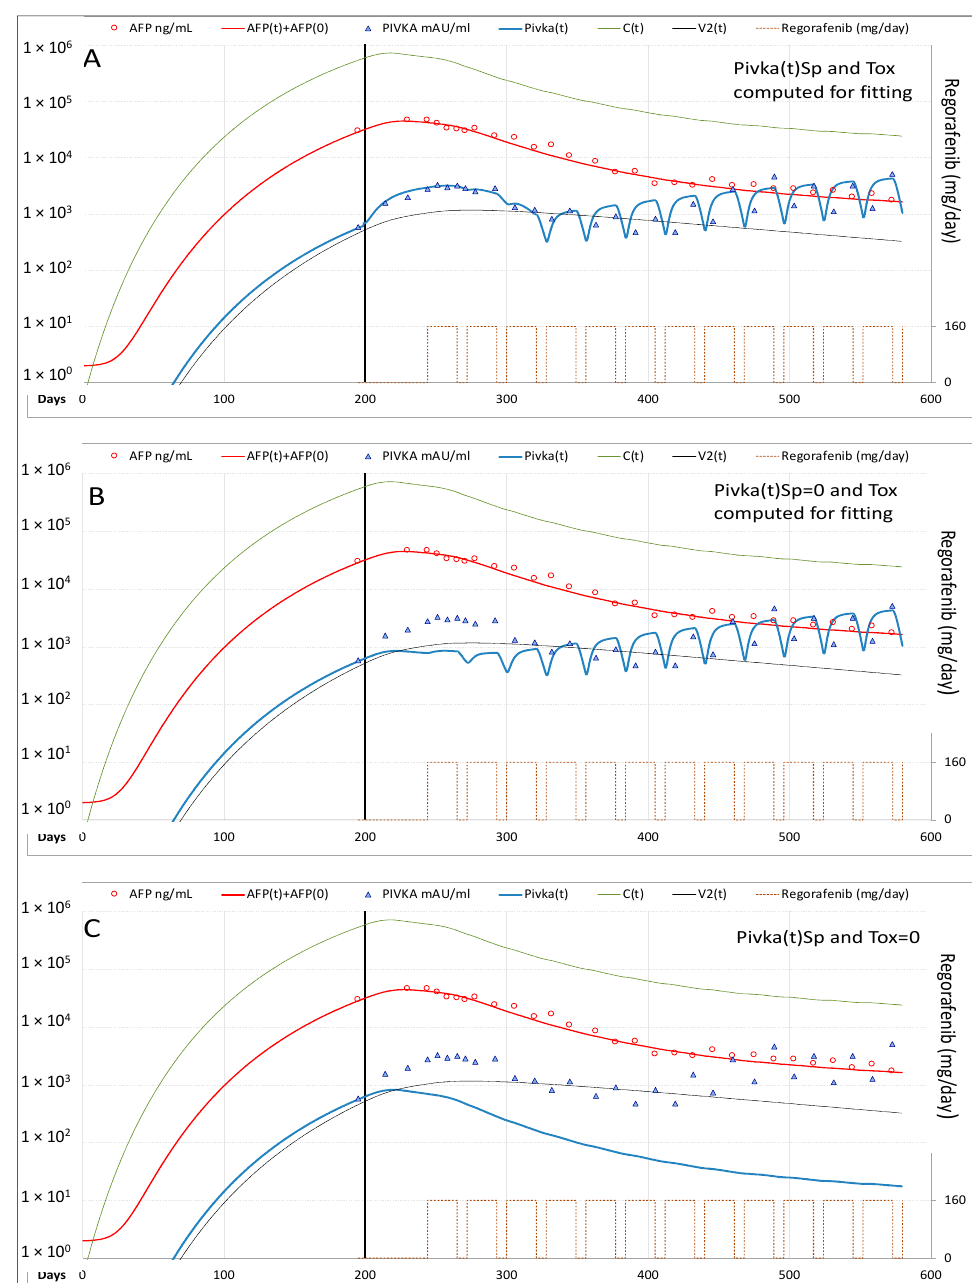
Figure 6. Model fitting of measured variables in Case-3 ( A ) Best fitting of AFP and PIVKA-II serum levels. AFP decline well correlated to C(t) decline, whereas PIVKA-II levels showed more complex kinetics, which appear influenced by the schedule of regorafenib treatment. The increase of PIVKA-II production observed in the first 3 months was fitted including in the model the potential effect of ischemia induced by the drug on cancer cells [Pivka(t) Sp]. The later PIVKA-II behavior, characterized by rapid fluctuations, was strongly influenced by the treatment schedule; this behavior could be explained considering that regorafenib may also exerted anti-vascular/toxic effects on non-tumor liver cells, that led to the production of a certain amount of PIVKA-II [Pivka(t) Tox]. ( B ) Best fitting of AFP and PIVKA-II obtained without including Pivka(t) Sp. ( C ) Best fitting of AFP and PIVKA-II obtained without including both Pivka(t) Sp and Pivka(t) Tox. Legend : AFP = measured AFP; AFP(t) = model computed AFP; AFP(0) = AFP normal value; PIVKA-II = measured PIVKA-II; Pivka(t) = computed PIVKA-II; C(t) = model computed cancer cells; V2(t) = model computed vascularization